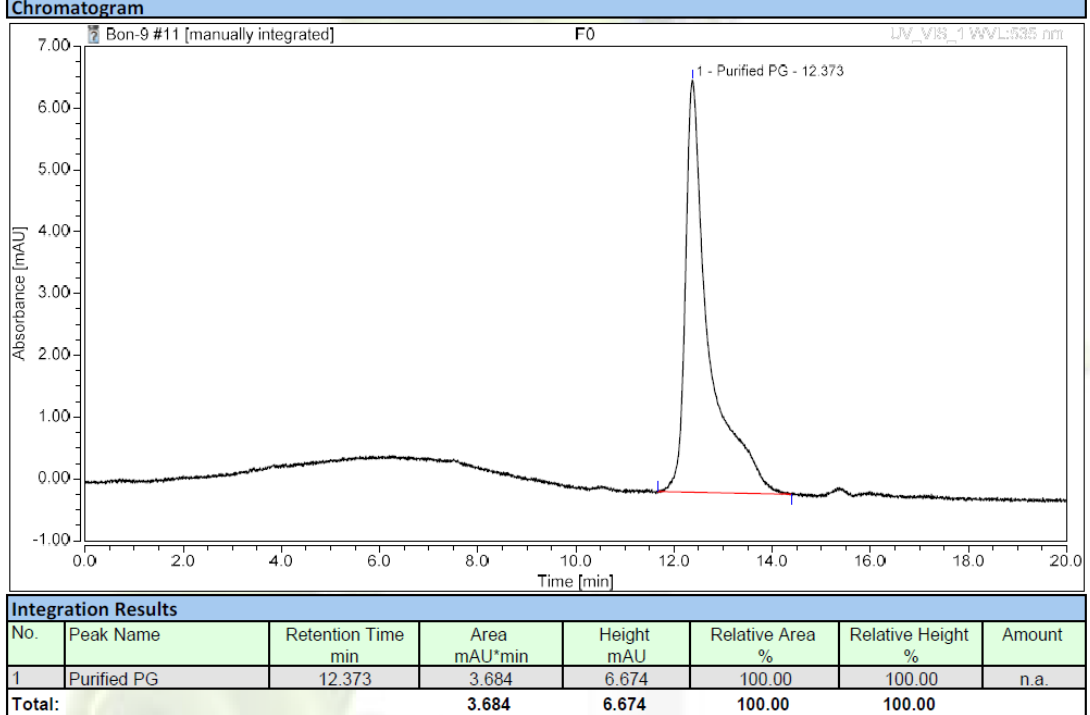
Figure 5. The high-performance liquid chromatography (HPLC) fingerprint of purified prodigiosin (PG) biosynthesized by S. marcescens CC17 in this